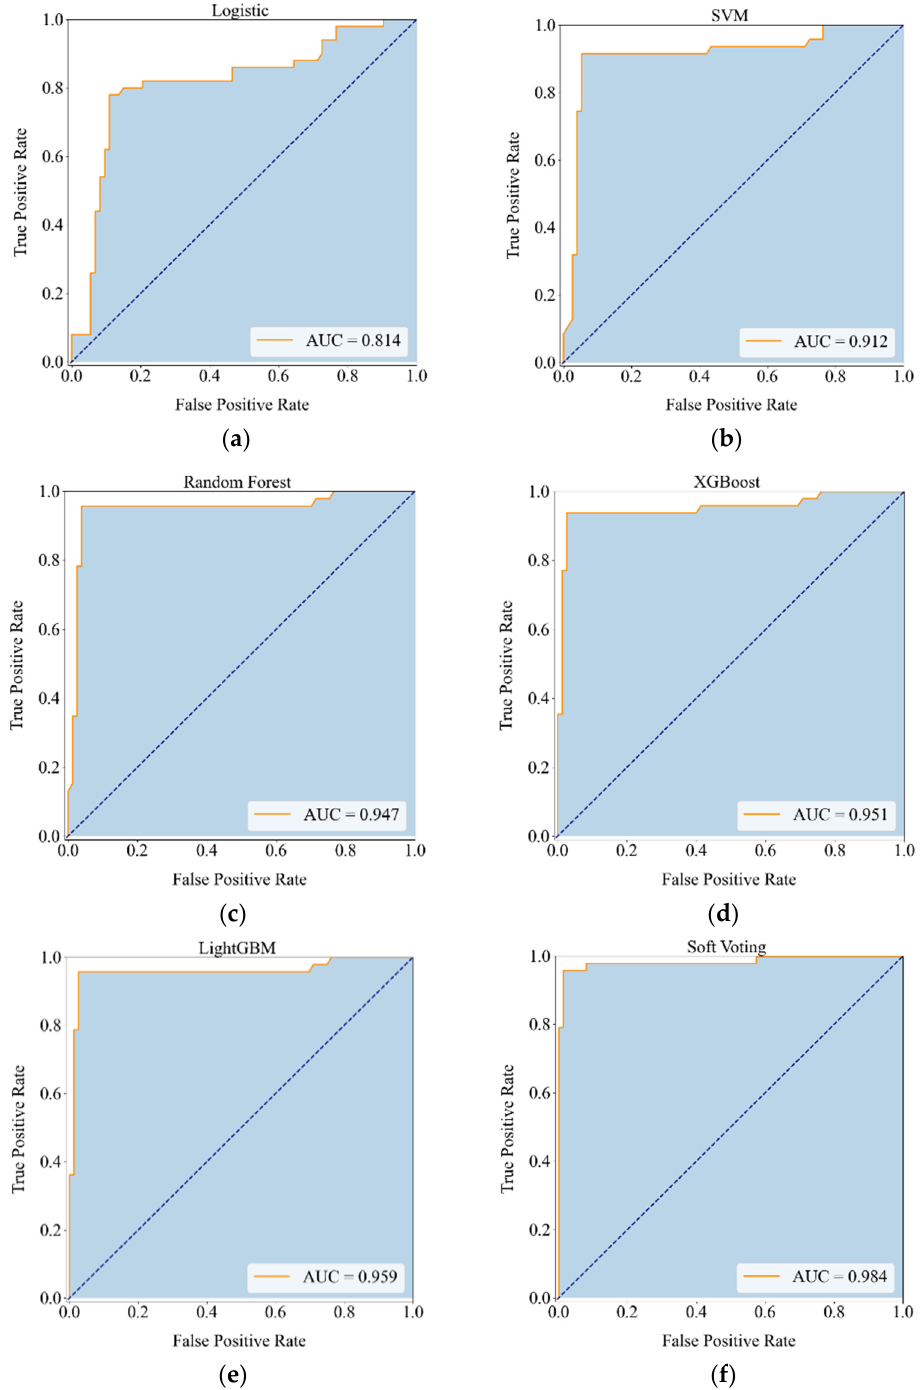
Figure 4. ROC curves of classifiers: ( a ) logistic regression; ( b ) SVM; ( c ) RF; ( d ) XGBoost; ( e ) LightGBM; ( f ) soft